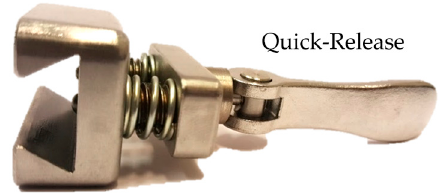
Figure 4. Spring plungers with quick-release.